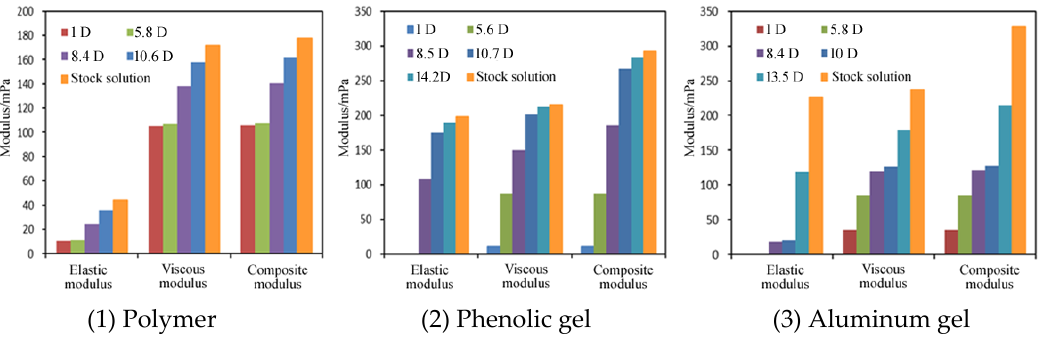
Figure 5. Changes of viscoelastic modulus of three solutions/gels before and after flowing through sand-packed cores with different permeabilities. sand-packed cores with different